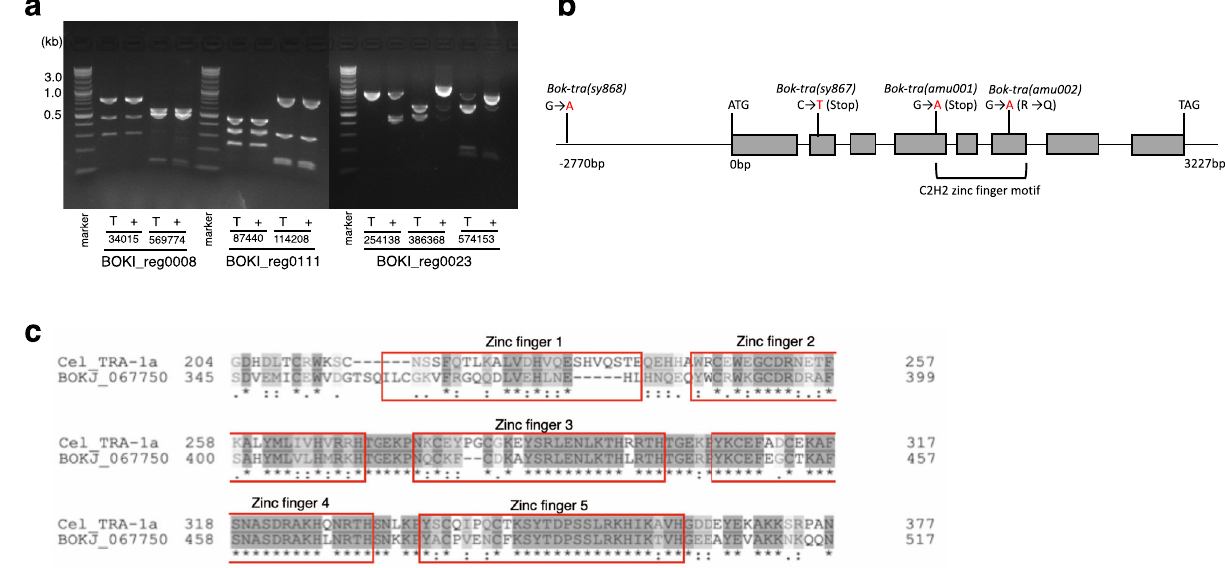
Fig. 5 Molecular characterization of mutations in B. okinawaensis . SNP mapping for Bok-tra(sy867) ( a ). Each pair of lanes shows results from the SNP for each primer pair located in three regions (reg0008 on chr2, 0023 on chr3, and 0111 on chr5), using either the adult pseudomale of Tra (T) or adult hermaphrodite of wild-type ( + ) DNA template. Linkage is visible as an increase in the proportion of SH1 DNA in Tra lanes compared to the wild-type lanes, and is visible on BOKI.reg0023 in all primer sets. Gene structure of Bok-tra-1 (BOKJ_0677500) and location of Bok-tra-1 mutations ( b ). The conservation of the zinc- fi nger domain in TRA-1 between C. elegans and B. okinawaensis ( c ). The fi ve zinc fi ngers are enclosed and